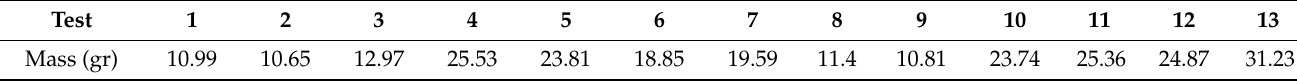
Table 4. Final mass of